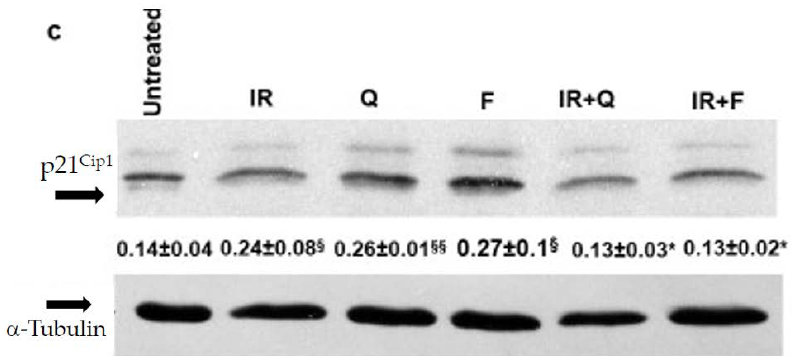
Figure 9. Changes in senescence markers following senolytic treatments in SAOS400 and HT500 cell lines. Immunoblot analysis of p16 INK4 expression in SAOS400 cells (panel a ) pre-irradiated (10 Gy) and treated with F (40 µ M) or Q (40 µ M) for 48 h. Densitometric analysis (numbers between panels) was obtained normalizing the expression of p16 INK4 with α − tubulin and quantified as described in the Methods section. * p < 0.05 vs. Q and IR; ** p < 0.01 vs. F and IR. Immunoblots of p16 INK4 (panel b ) and p21 CIP1 (panel c ) expressions in HT500 cells pre-irradiated (10 Gy) and treated with 40 µ M F or 40 µ M Q for 72 h. Densitometric analyses (numbers between panels) were obtained normalizing the expressions of p21 CIP1 and p16 INK4 with α -tubulin and quantified as described Methods section. § p < 0.05 vs. untreated; §§ p < 0.01 vs. untreated; * p < 0.05, ** p < 0.01 vs. F plus Q and